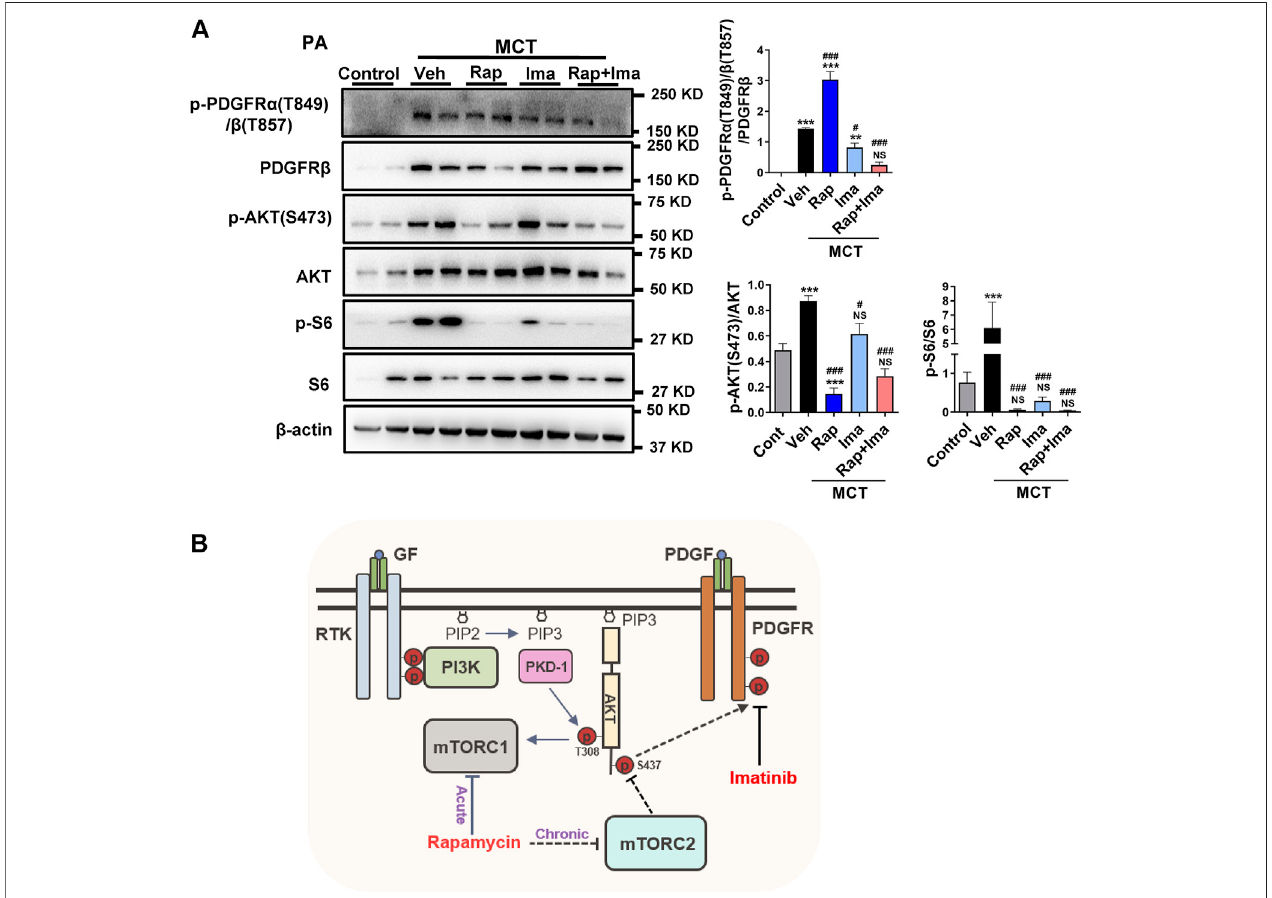
FIGURE 8 | Effects of rapamycin combined with imatinib on mTOR and PDGFR signaling pathways in pulmonary artery. (A) Pulmonary artery vessels of were isolated for protein extraction, and the expression of mTORC 1, mTORC 2 and PDGFR signaling pathway related proteins were detected by immunoblotting. Data are presentedasthemean ± SE.One-wayANOVAfollowedbyGraphpadprismwasusedforstatisticalanalysis.NSmeansnosigni fi cant.*** p < 0.001;** p < 0.01;* p < 0.05 versus control. ### p < 0.001; ## p < 0.01; # p < 0.05 versus MCT with vehicle. (B) The schematic representation of the fi ndings of this study: rapamycin chronic treatment in hPASMCs induced the highly expression of phosphorylation of PDGFRs. Imatinib inhibits phosphorylation of PDGFR α / β induced by rapamycin. Abbreviations: GF, growth factors; RTK, receptor tyrosine kinase; PDGF, platelet derived growth factor; PDGFR, platelet derived growth factor receptor; PI3K, phosphoatidylinositol 3-kinase; PIP2, phosphatidylinositol-4,5-bisphosphate; PIP3, phosphatidylinositol-3,4,5-bisphosphate; mTORC1, mTOR complex 1; mTORC2, mTOR complex 2.